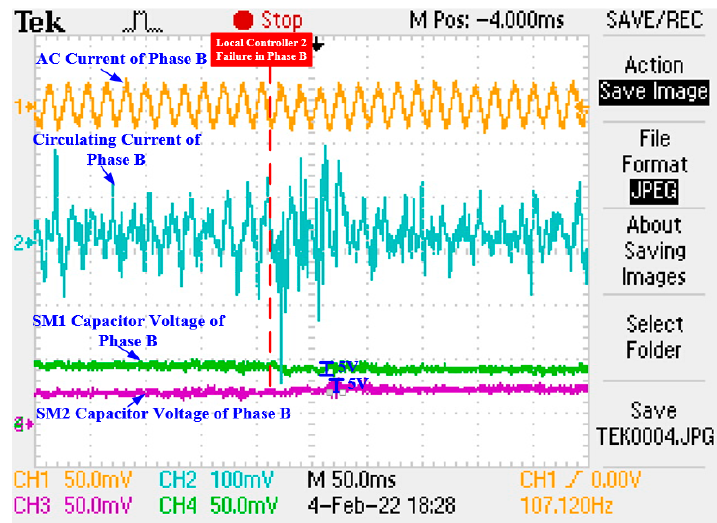
Figure 21. Result validation of Figure 17 with Opal-RT.